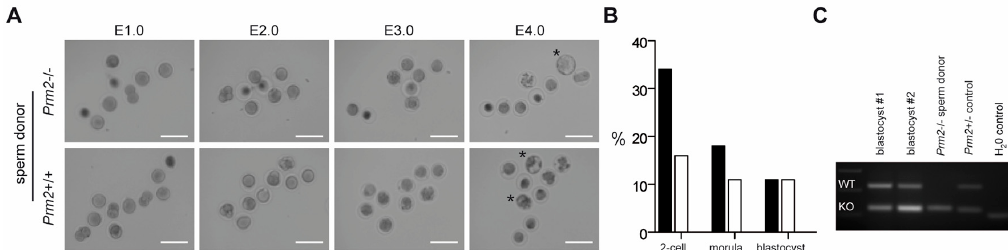
Figure 7. Infertility of Prm2 -deficient males can be overcome by ICSI of testicular sperm. ( A ) Representative photomicrographs showing the in vitro development of oocytes upon ICSI of wildtype (bottom row) or Prm2 -deficient sperm (top row) between embryonic day 1 and 4 (E1.0-E4.0). Blastocyst stage embryos are highlighted by asterisks. ( B ) ICSI statistics. ( C ) Genotyping of blastocysts derived from ICSI of Prm2 − / − sperm into wildtype oocytes. DNA from the Prm2 − / − sperm donor and a heterozygous animal served as controls.